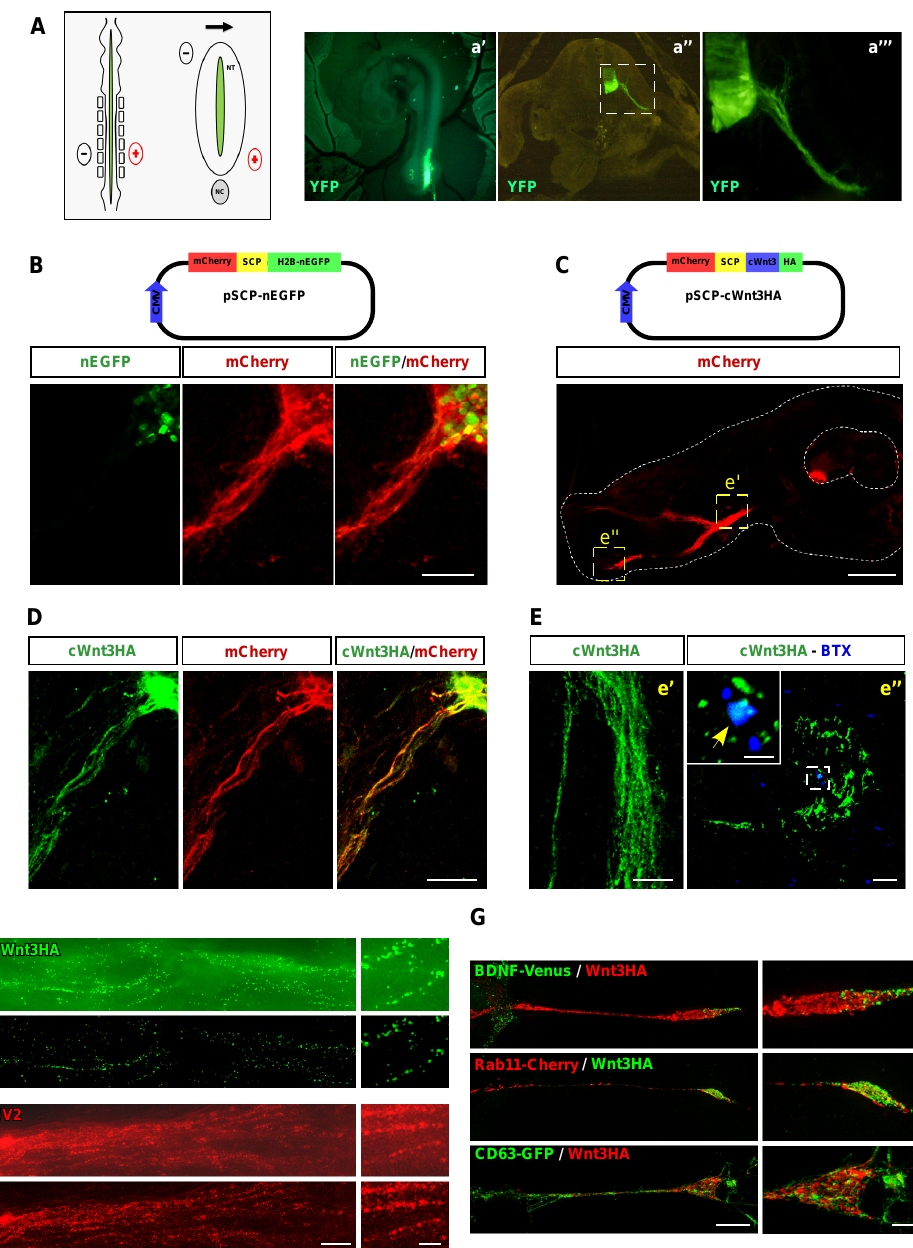
Figure 2. Overexpressed Wnt3 distributes in a vesicular-like pattern along motor axons and reaches the neuromuscular junction area in the limb region of developing chick embryos. ( A ) Schematic diagrams showing the in ovo electroporation approach. The DNA is microinjected into the central canal of the neural tube and electrodes are positioned to target motor neuron somas in the ventral spinal cord. The arrow indicates DNA migration. NT: neural tube; NC: notochord). ( a (cid:48) – a (cid:48)(cid:48)(cid:48) ) Panels show a HH16 chick embryo electroporated to express YFP. Positive YFP signal (green) distributes in somas and axons at the right ventral neural tube, as visualized in ( a (cid:48) ) the whole embryo, as well as in transversal sections at ( a (cid:48)(cid:48) ) low (Bar, 100 µ m) and ( a (cid:48)(cid:48)(cid:48) ) high magnification (Bar, 50 µ m). ( B ) The ventral neural tube of HH16 chick embryos was electroporated with the pSCP-nEGFP plas- mid. After 24 h, transversal sections show nuclear EGFP and membrane-anchored mCherry expres- sion in ventral motor neurons (Bar, 30 µ m). ( C ) HH16 chick embryos were electroporated with the pSCP-cWnt3HA plasmid. A low magnification image shows mCherry distribution in motor